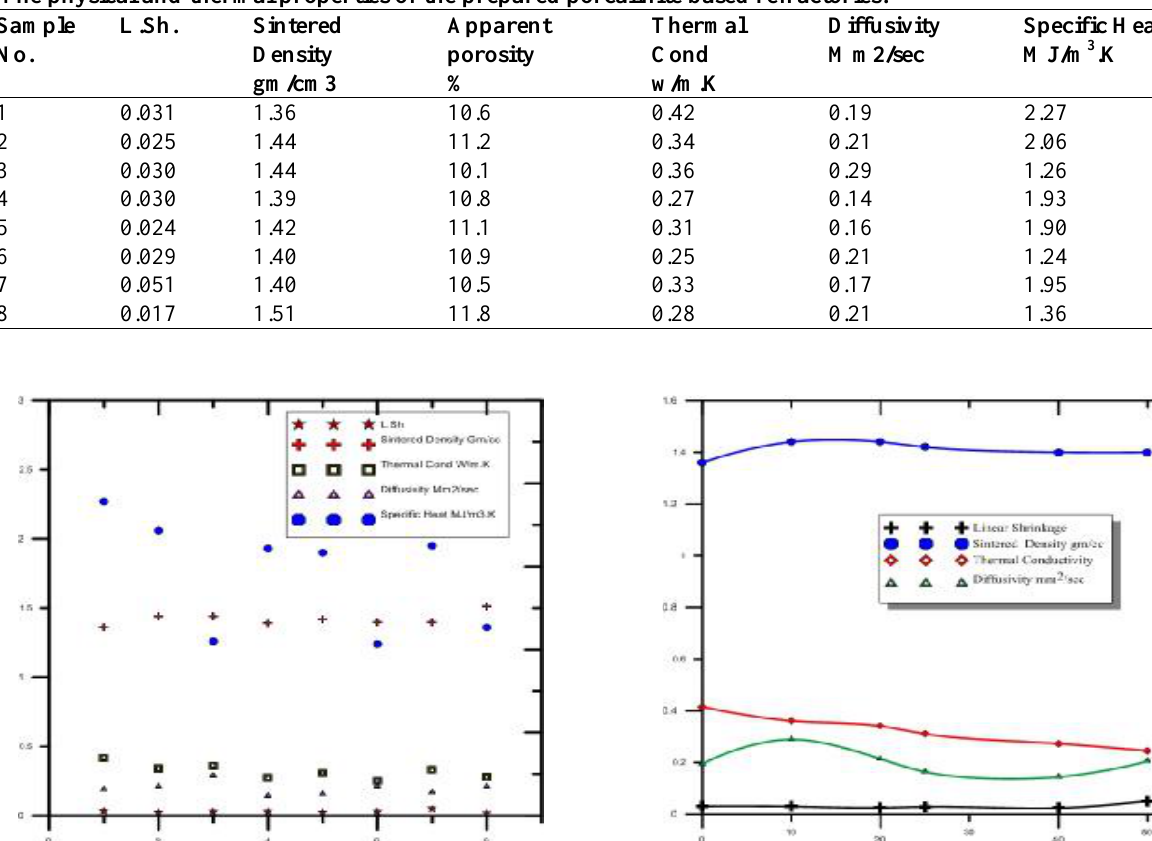
The physical and thermal properties of the prepared porcalinite based refractories.